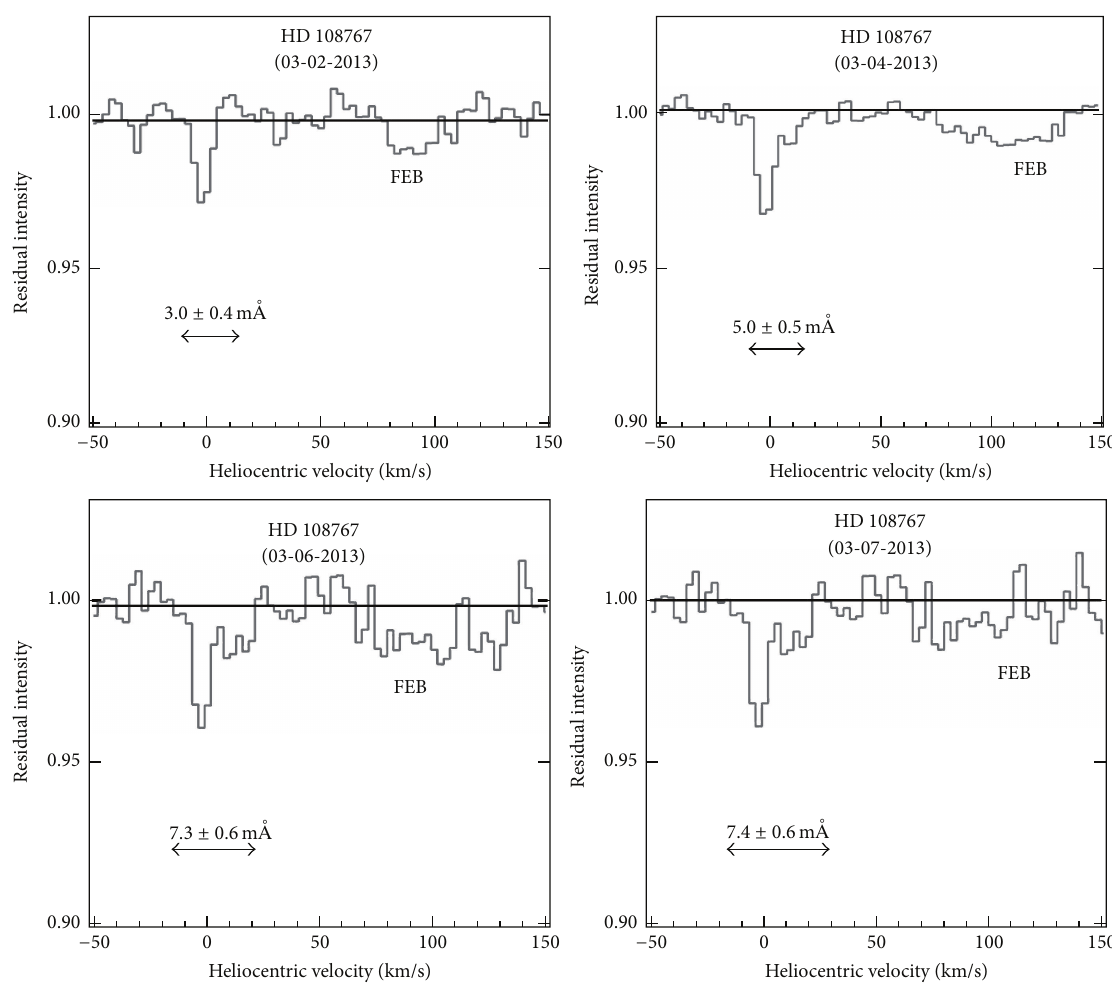
Figure 4: The circumstellar CaII K-line absorption spectra of HD 108767 recorded on 4 nights in March 2013. Note the appearance of the extra absorption to the main CaII line at +10km s −1 on 03-06-2013 and 03-07-2013. In addition an FEB absorption event with varying strength is observed on all 4 nights at 𝑉 ∼ +100 km s −1